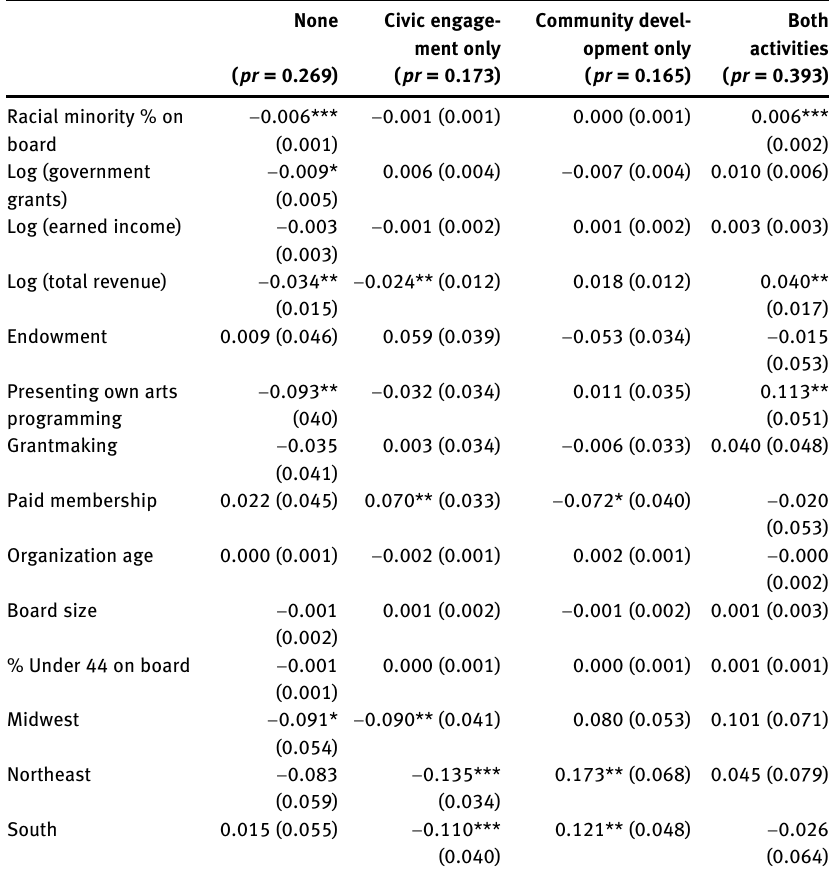
Table  : Average partial effects ( N =  ).